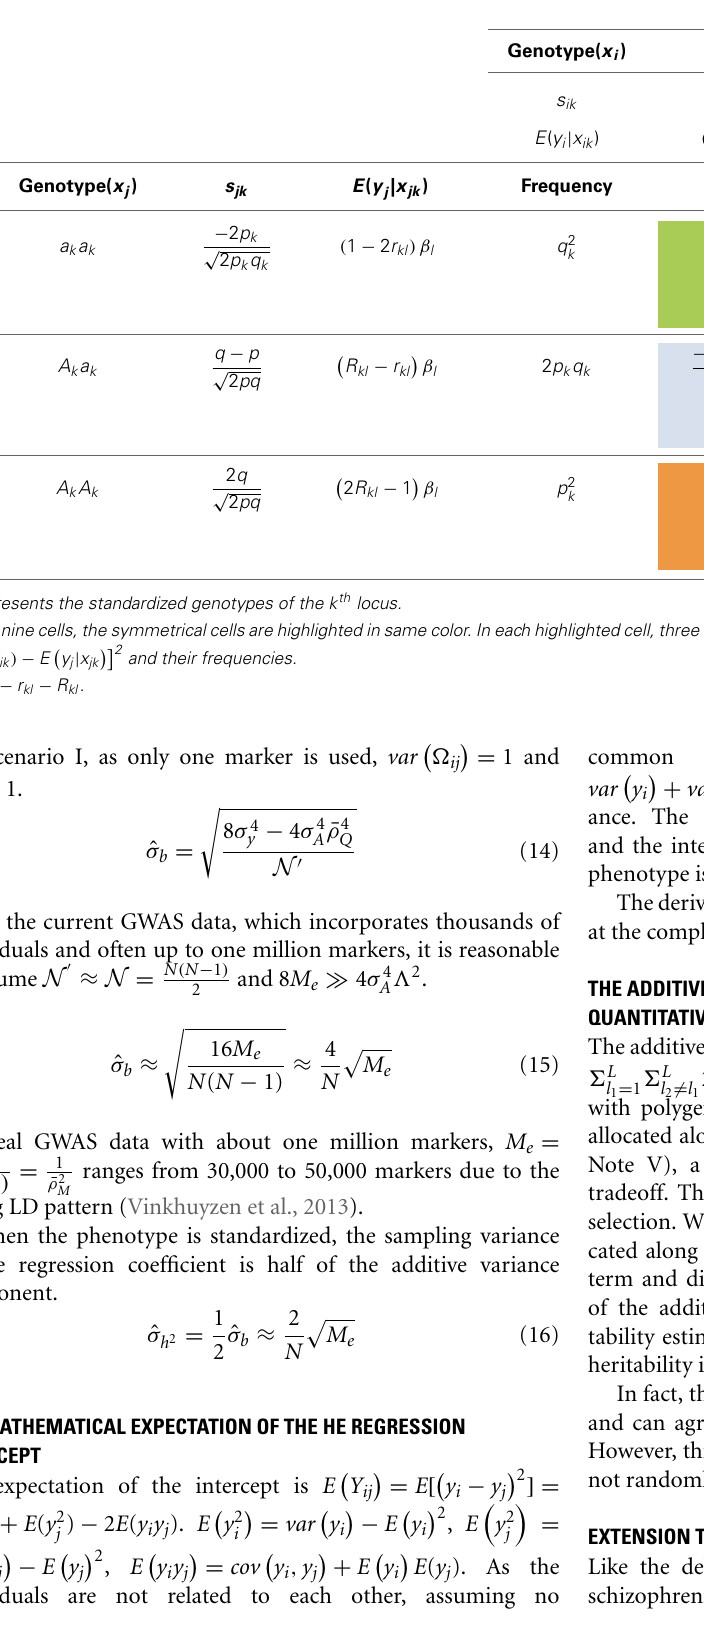
Table 5 | The joint distribution of E ( (cid:2) ij ) andE ( Y ij | x i , x j ) for one marker and one QTL.